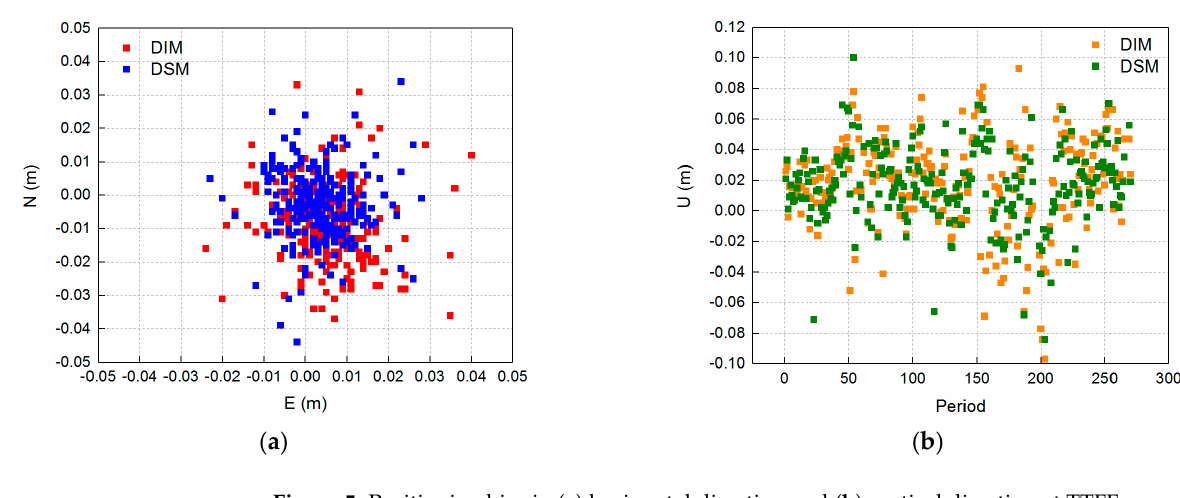
Figure 5. Positioning bias in ( a ) horizontal direction and ( b ) vertical direction at TTFF.